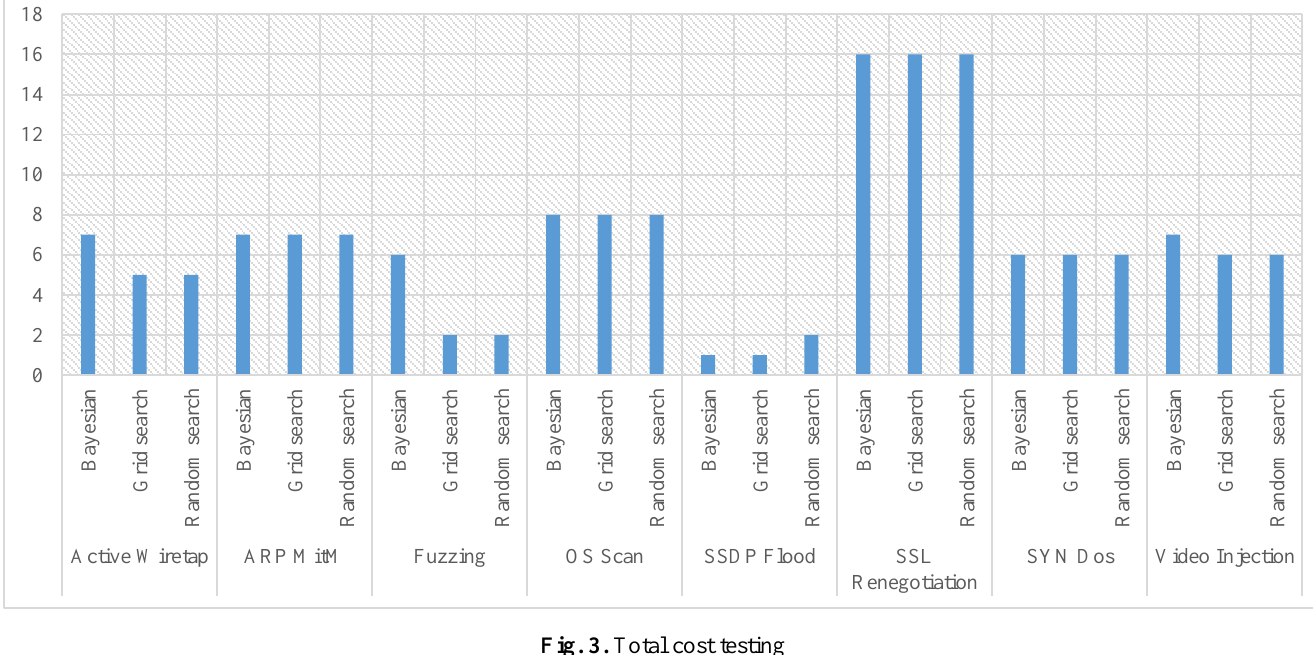
Fig. 3. Total cost testing